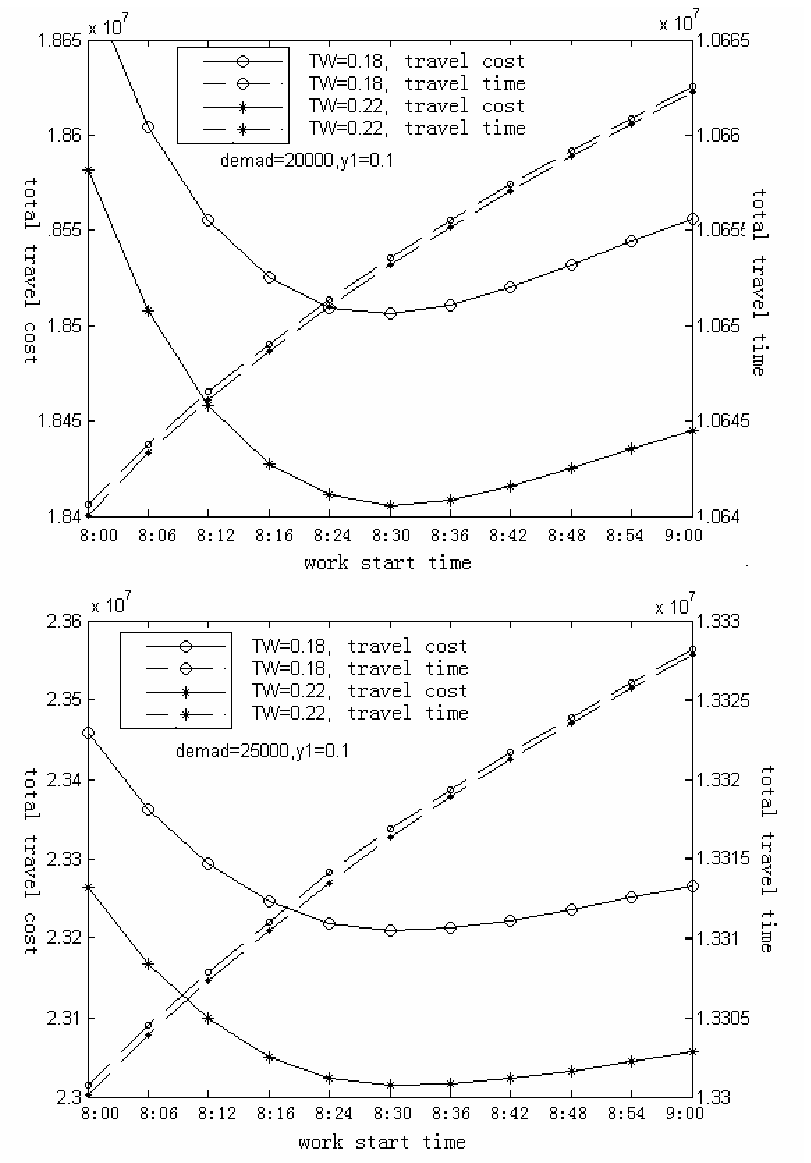
Fig 3 . Total system time and cost with respect to work start